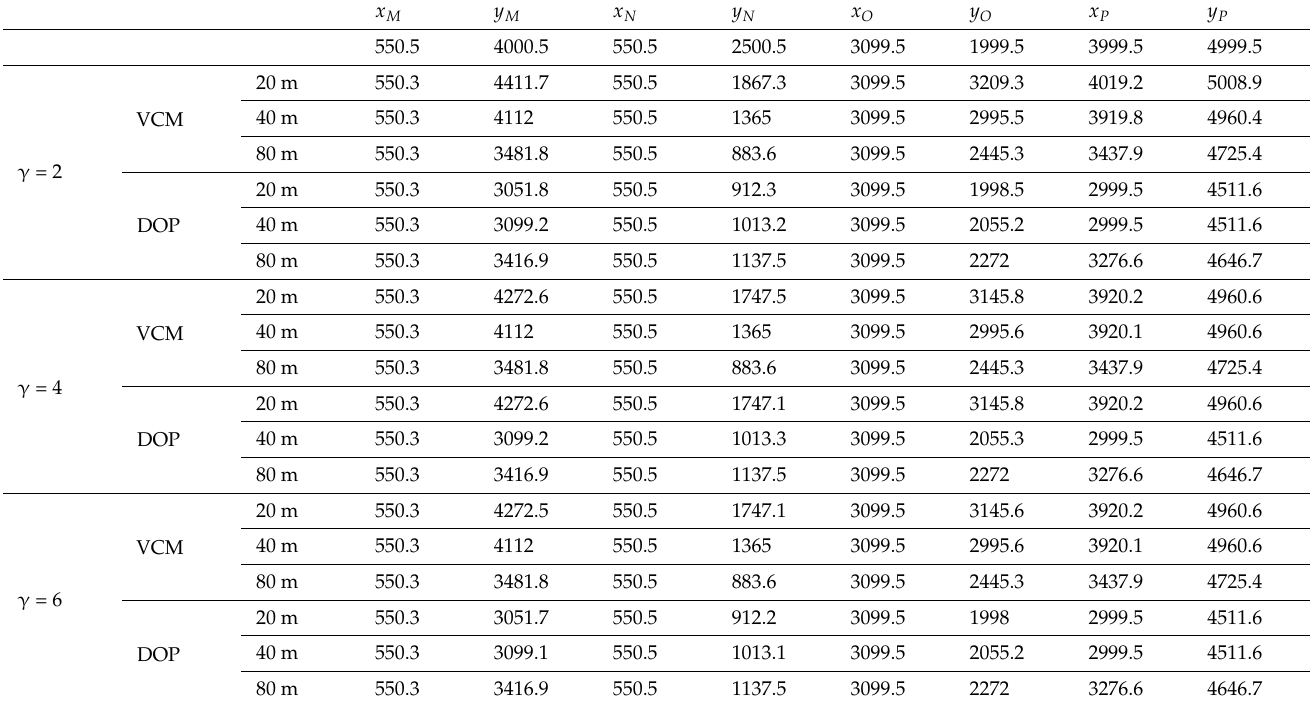
Table 1. Coordinates of the monitoring stations (MSs) in metres before and after optimisation with different resolutions, pathloss exponents and the VCM and DOP criteria